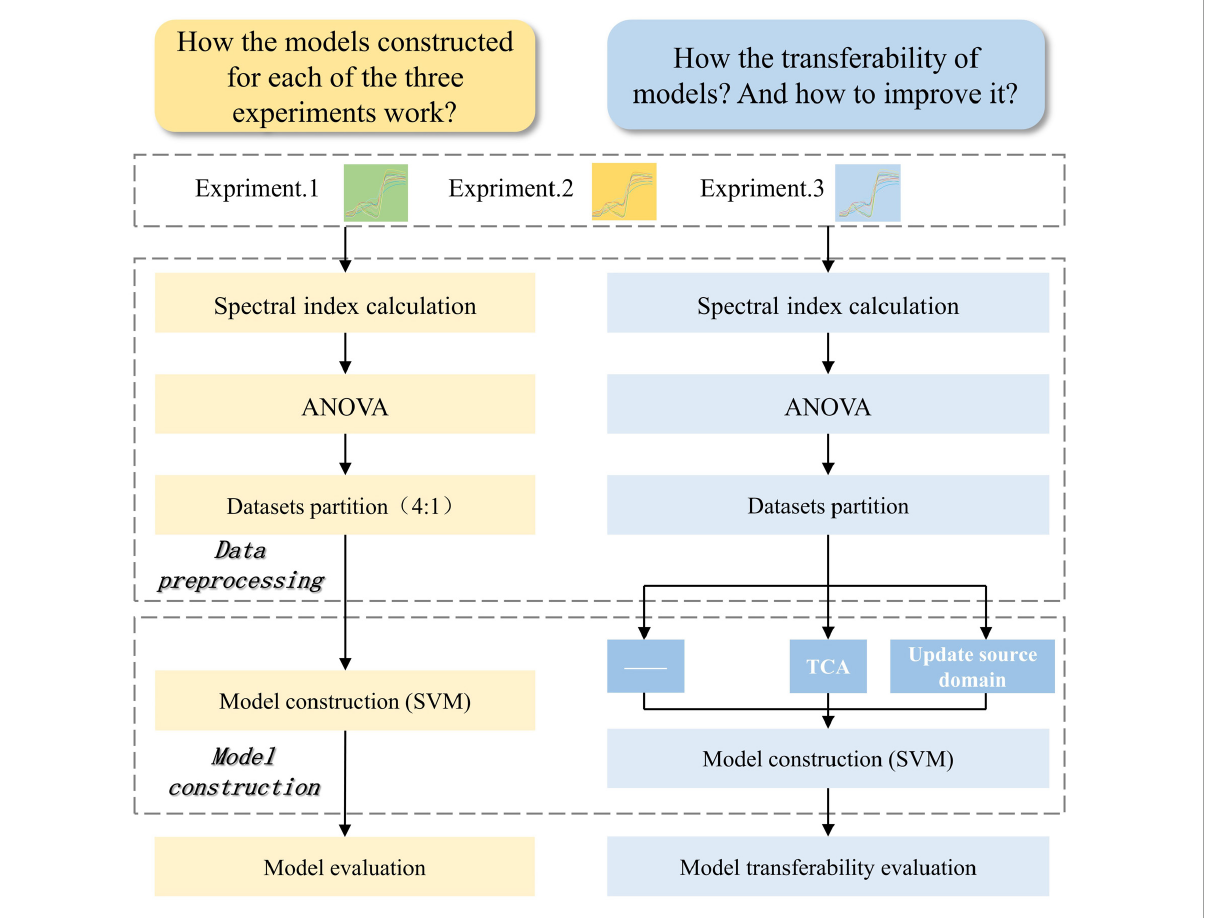
FIGURE2 The flowchart of spectral data analysis for glyphosate-resistant cultivar identification. Yellow represents the data flowchart to answer to question that how the models constructed for each of the three experiments work. Blue represents the data flowchart to answer to question that how the transferability of models and how to improve it. ANOVA, analysis of variance. SVM, support vector machine. TCA, transfer component